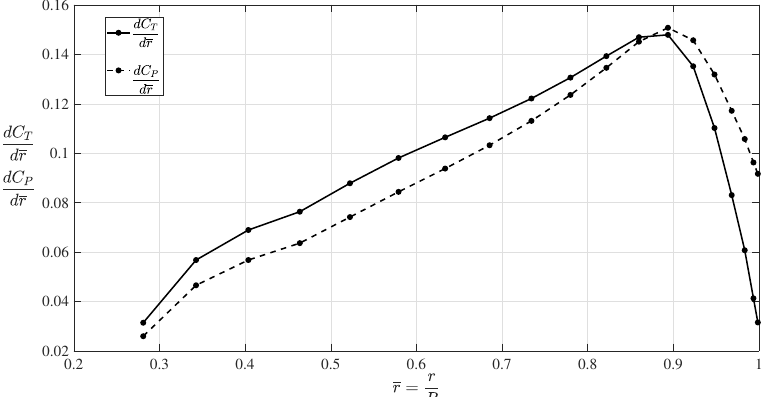
Figure 2. Dimensionless thrust (solid line) and power (dashed line) derivatives distribution along with the non-dimensional